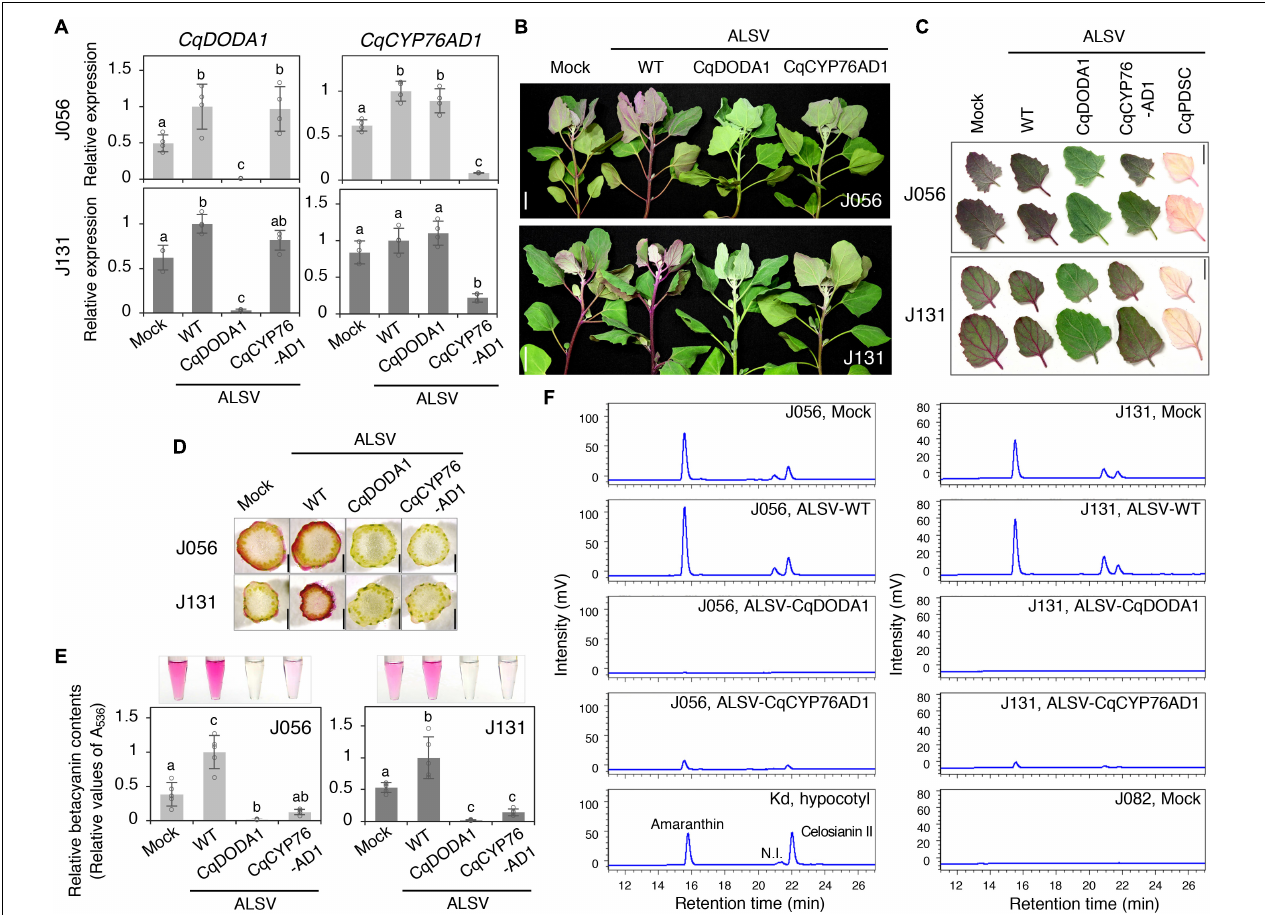
FIGURE 3 | Silencing of CqDODA1 and CqCYP76AD1 inhibits betalain production in quinoa. (A) RT-qPCR analysis of CqDODA1 and CqCYP76AD1 transcripts in the uninoculated upper leaves of the inbred lines J056 and J131 inoculated with the indicated inocula. Data were normalized to quinoa polyubiquitin 10 ( CqUBQ10 ) expression and are shown as means ± SD ( n = 4). Different letters indicate significant differences by a Tukey’s HSD test ( p < 0.05). (B) Representative images of quinoa plants at 28 dpi with mock buffer, ALSV-WT, ALSV-CqDODA1, and ALSV-CqCYP76AD1. Scale bars represent 2 cm. (C) Representative images of the uninoculated upper leaves of quinoa plants at 20 dpi with the indicated inocula. Scale bars represent 2 cm. (D) Representative images of stem cross-sections of plants at 28 dpi with the indicated inocula. Scale bars represent 1 mm. (E) Relative quantification of betacyanin content was assessed spectrophotometrically by light absorption measurements at 536 nm. Relative values are presented as means ± SD ( n = 5). Betacyanin pigments were extracted from the uninoculated upper leaves of quinoa plants (inbred J056 and J131 lines) at 16 dpi inoculated with the indicated inocula. Representative images of aqueous extracts used for the measurements are shown. (F) High performance liquid chromatography analysis of betacyanin pigments in the aqueous extracts used in (E) . The peak names of quinoa betacyanins composed of amaranthin, celosianin II, and a non-identified (N.I.) compound were identified based on the analysis of red-violet pigment extracted from hypocotyls of 14-day-old Kd plants (Imamura et al., 2019). No betacyanin peaks were detected in the uninoculated upper leaves of J082 inbred line plants inoculated with mock. The horizontal and vertical axes indicate the retention time (min) and signal intensity (mV), respectively.